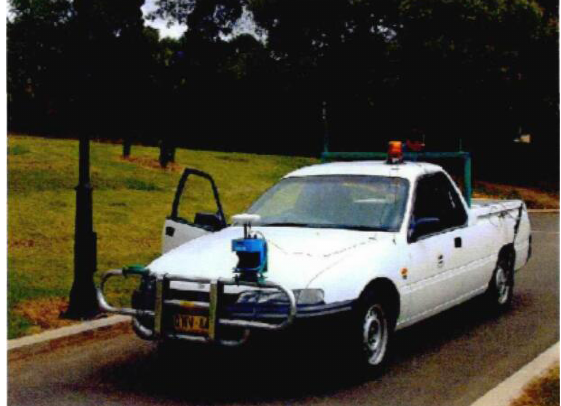
Figure 9. The mobile test platform used by the